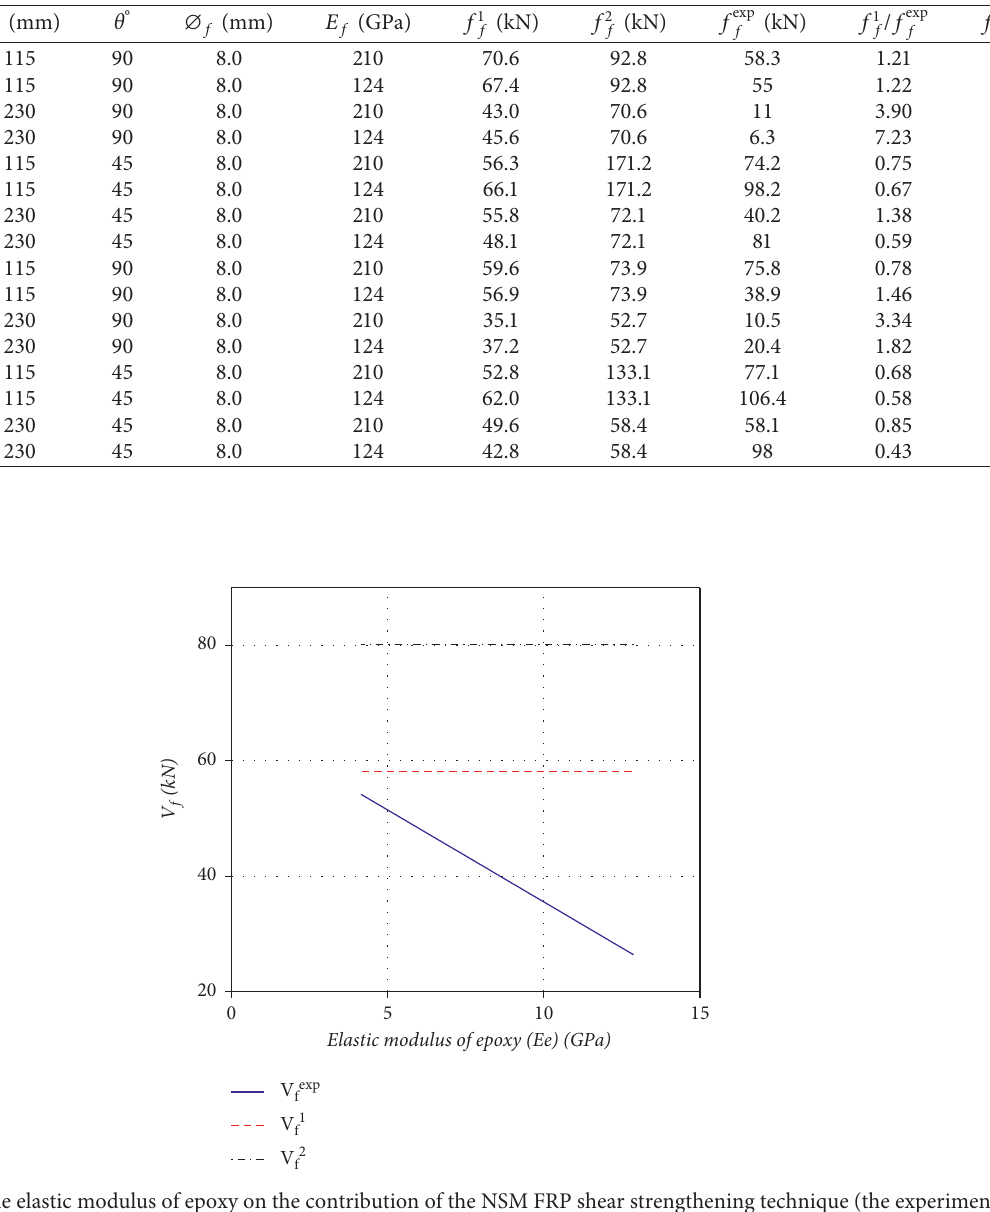
Table 6: Comparison between experimental results [90] and analytical results.